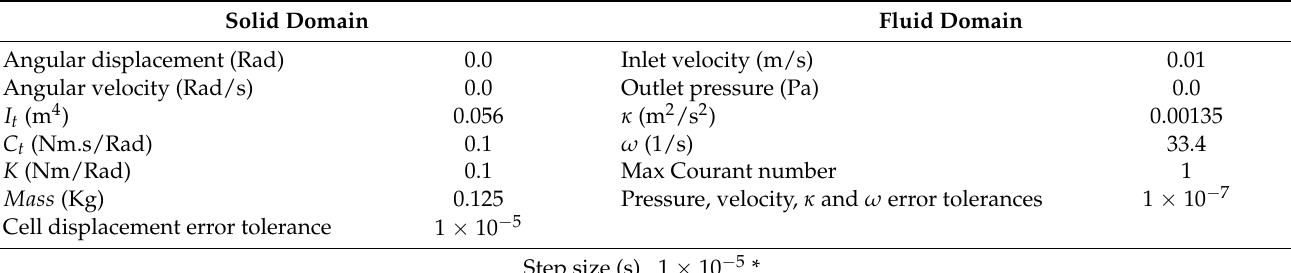
Table 2. Initial conditions for solid and fluid